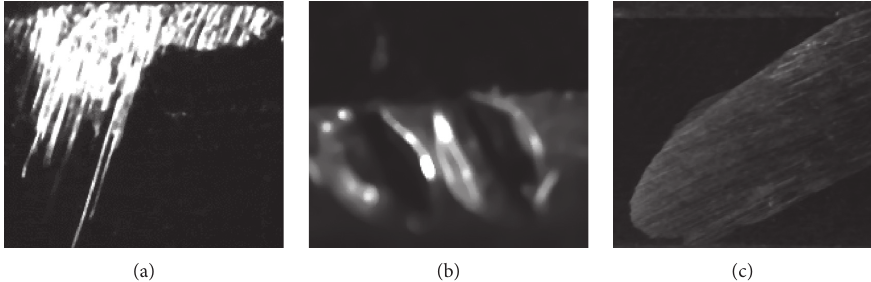
Figure 2: Three types of bearing defects. (a) Abrasion: wear caused by friction between a bearing and a rough object as it moves on a production line. (b) Bruise: when moving between stations, the bearing transfer device does not fix the bearing, which causes concavity from the collision between the bearing and other objects. (c) Overgrinding: in the machining process, excessive grinding of the bearing is caused by machine vibration or incorrect parameter